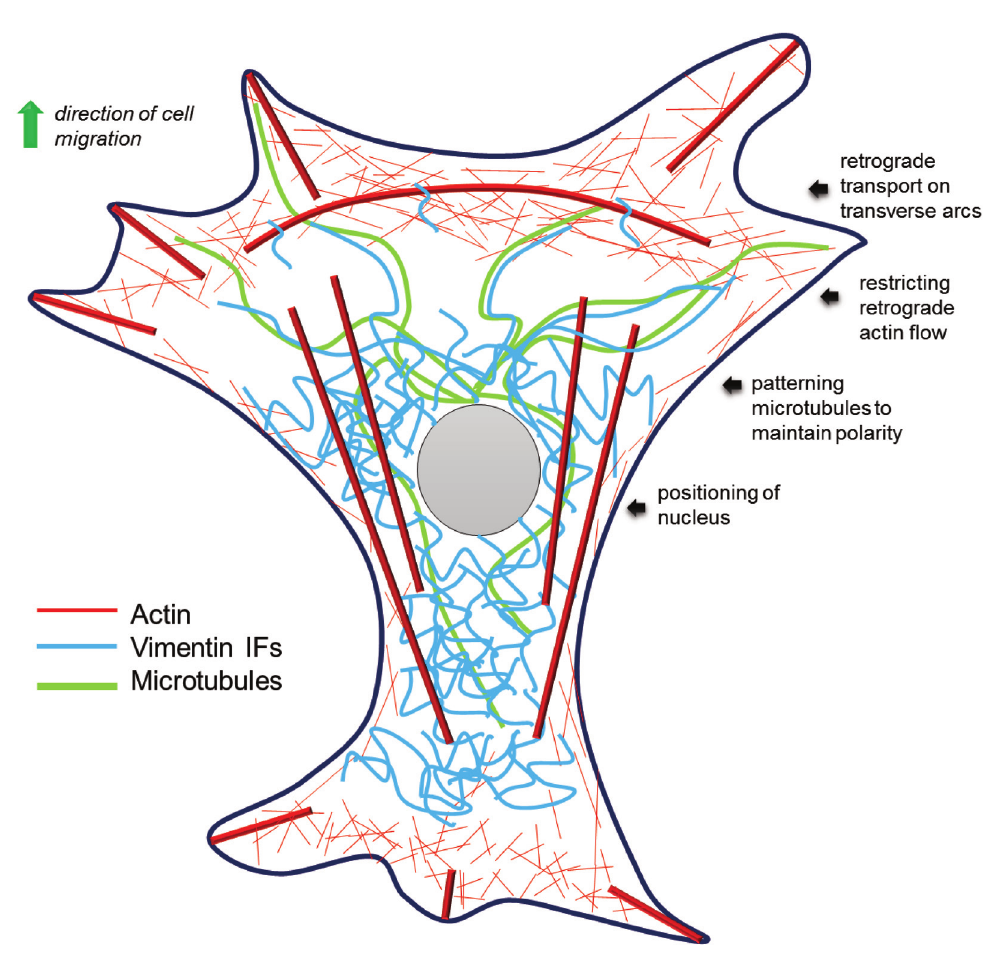
Figure 1. Vimentin promotes directed cell migration by coordinating the dynamics of actin filaments and microtubules. Vimentin particles disassemble at the cell periphery and undergo retrograde transport on transverse actin arcs for likely incorporation into mature filaments. Mature vimentin filaments restrict retrograde actin flow and control nuclear positioning during cell migration. Long-lived vimentin filaments coordinate the maintenance of cell polarity during migration by closely associating with relatively short-lived microtubules to pattern the growth of new microtubules along their preceding tracks. IF, intermediate filament.